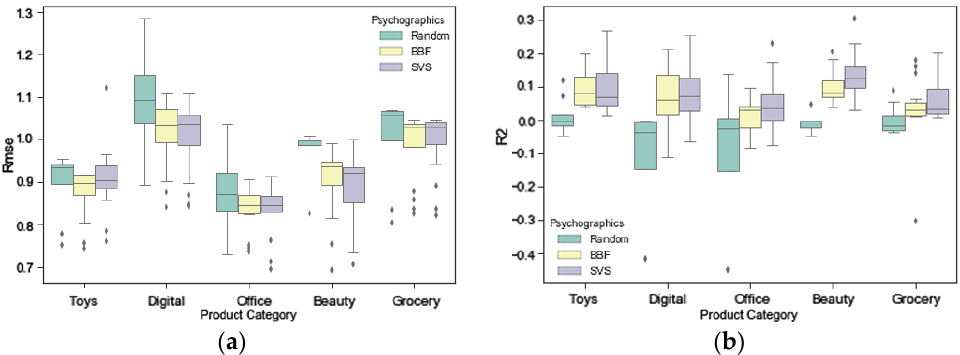
Figure 5. Mean values of RMSE and R 2 about three segmentation variables across different product Categories. ( a ) Mean values of RMSE; ( b ) Mean values of R 2 .